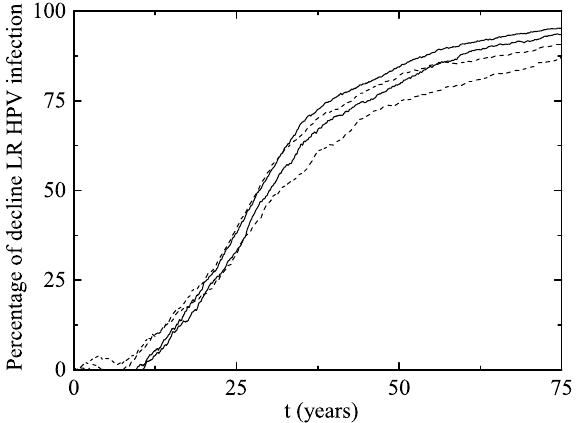
Figure 5. Percentage of decline of men and women aged 27–64 infected of LR HPV 6 and/or 11 (and consequently of GW) after the implementation of the vaccination program in both scenarios. The upper solid line corresponds to women in Scenario 1 and the lower solid line corresponds to women in Scenario 2. The upper and lower dotted lines correspond to men in Scenarios 1 and 2, respectively. Notice that no significant decline is observed in women or men aged 27–64 in almost the first 10